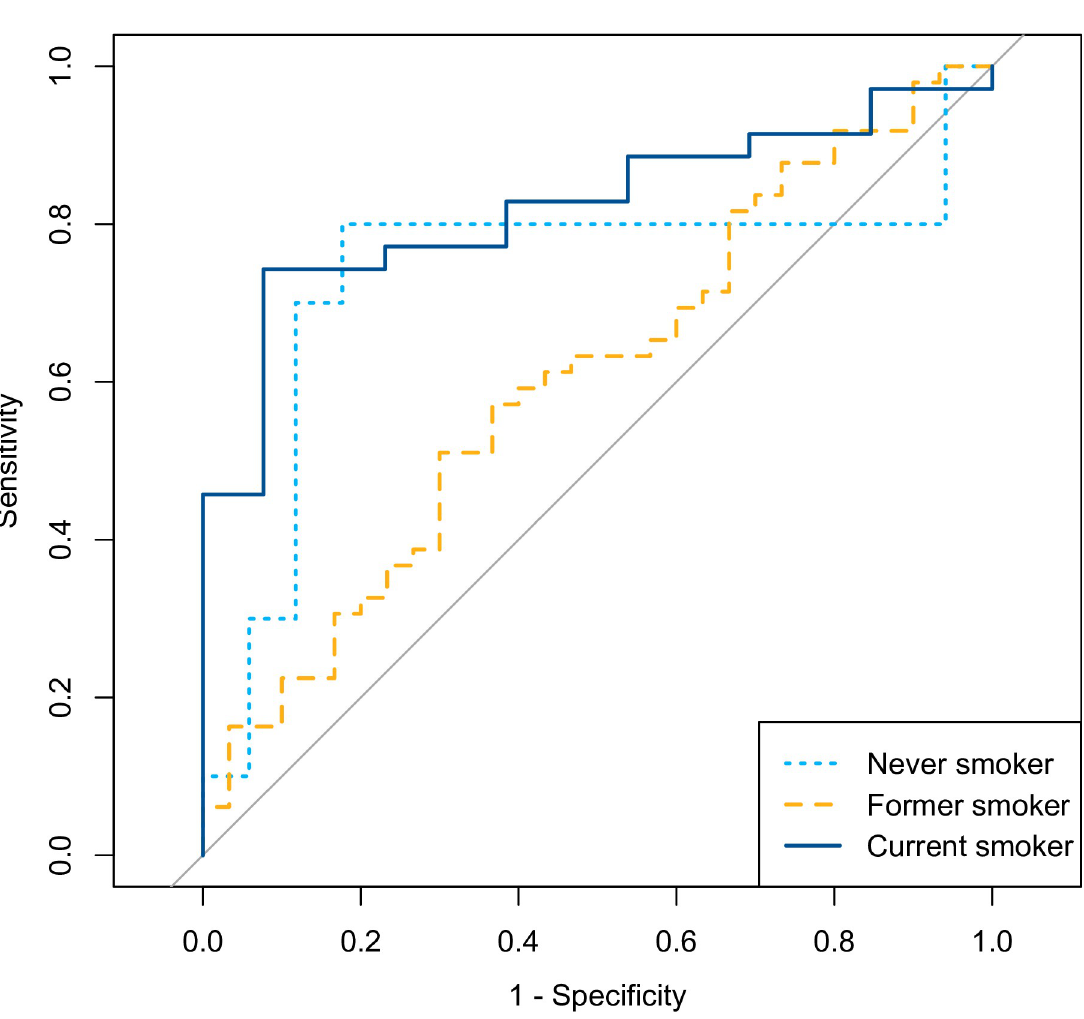
Fig 2. ROC curves for the three groups never smoker, former smoker, and current